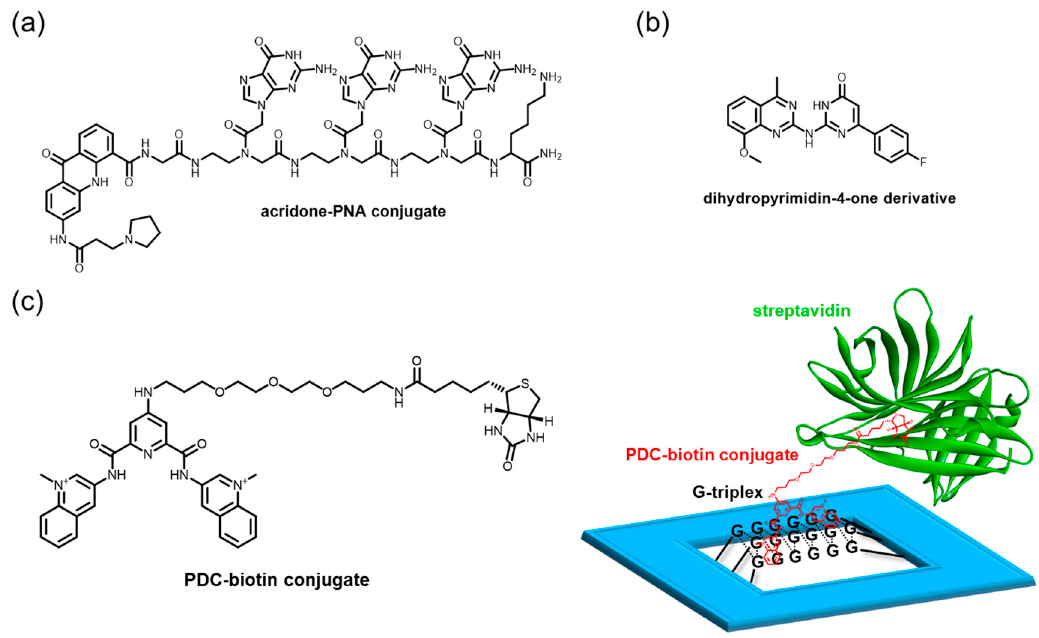
Figure 10. ( a – c ) G-triplex-targeting ligands. ( c ) A platform for their evaluation constructed by DNA origami.